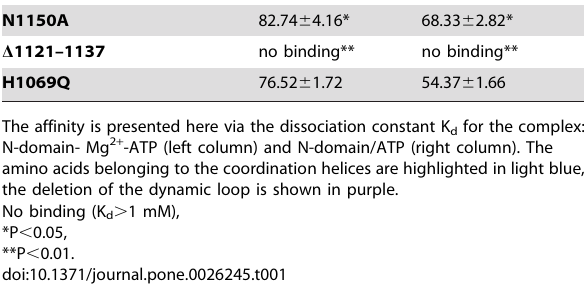
The affinity is presented here via the dissociation constant K d for the complex: N-domain- Mg 2 + -ATP (left column) and N-domain/ATP (right column). The amino acids belonging to the coordination helices are highlighted in light blue, the deletion of the dynamic loop is shown in purple. No binding (K d . 1 mM), *P ,